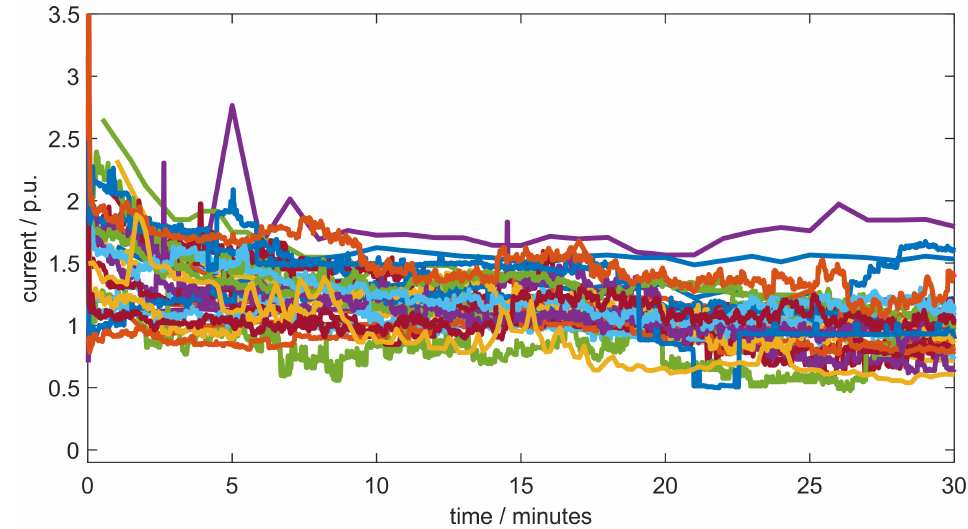
Figure 3. Normalized current during 31 reconnection events.